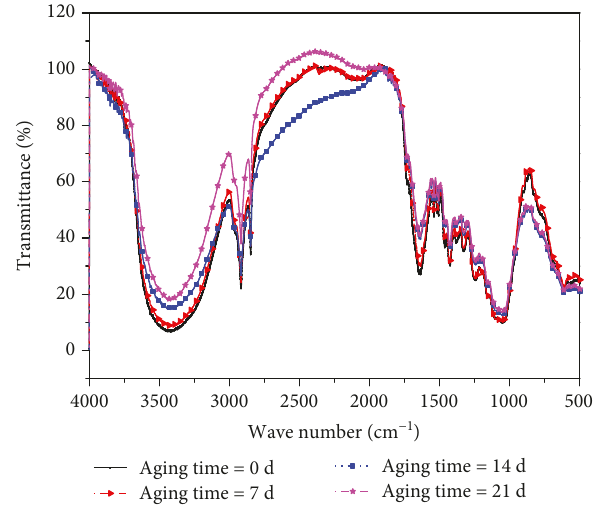
Figure 3: FTIR spectra of the composites.